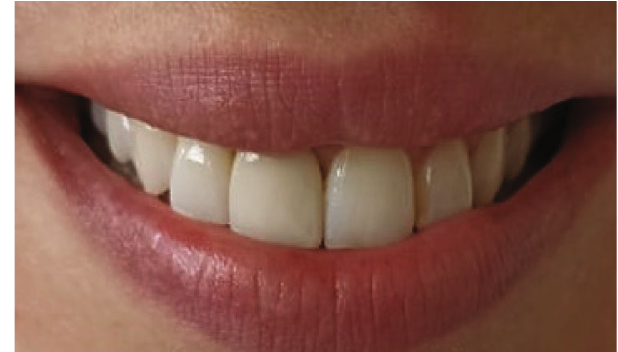
Figure 9: Final outcome showing unnoticed